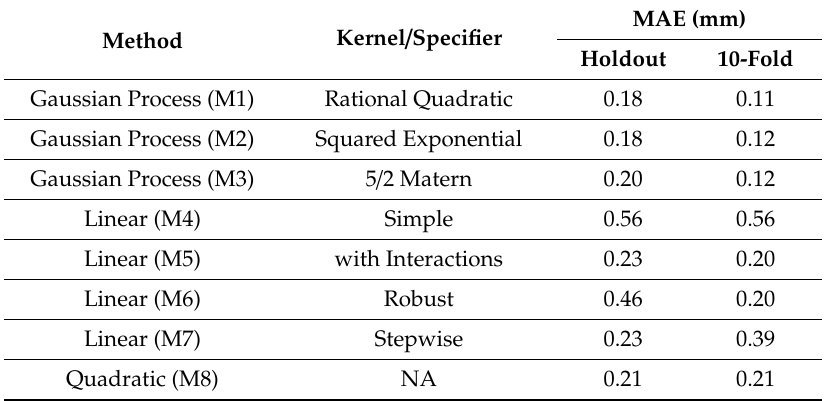
Table 1. Mean Absolute Error (MAE) for all models using holdout and 10-Fold validation with all nine features.